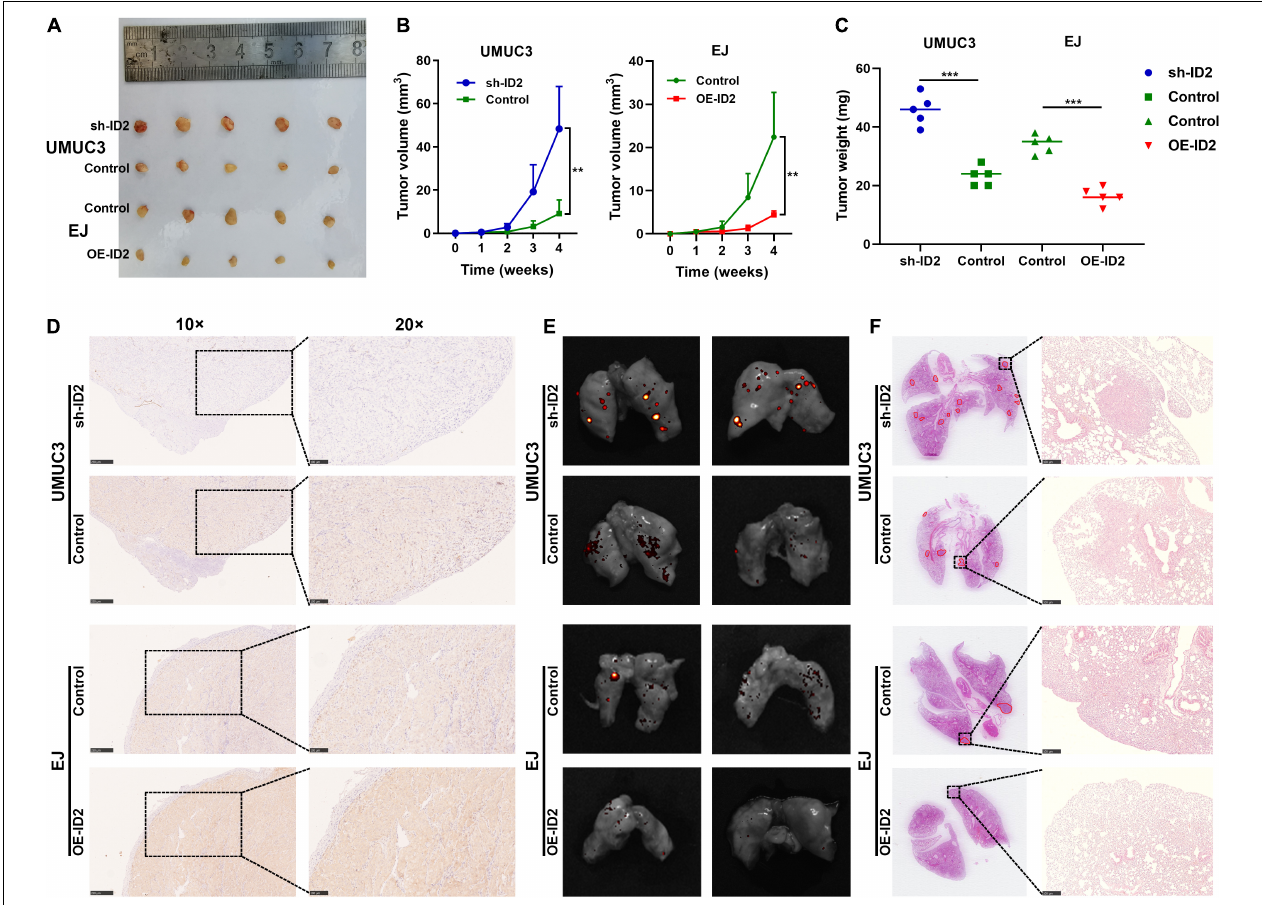
FIGURE 4 | ID2 suppressed the growth and metastasis of BCa cells in vivo . (A) Representative images of xenograft tumors in nude mice. (B) The growth curves of xenografts. (C) The tumor weight of xenografts. (D) IHC assay demonstrated the level of ID2 in pairs of tumors. (E,F) Representative in vitro imaging (E) and H&E images (F) of lung tissue sections (** p < 0.01, *** p < 0.001).